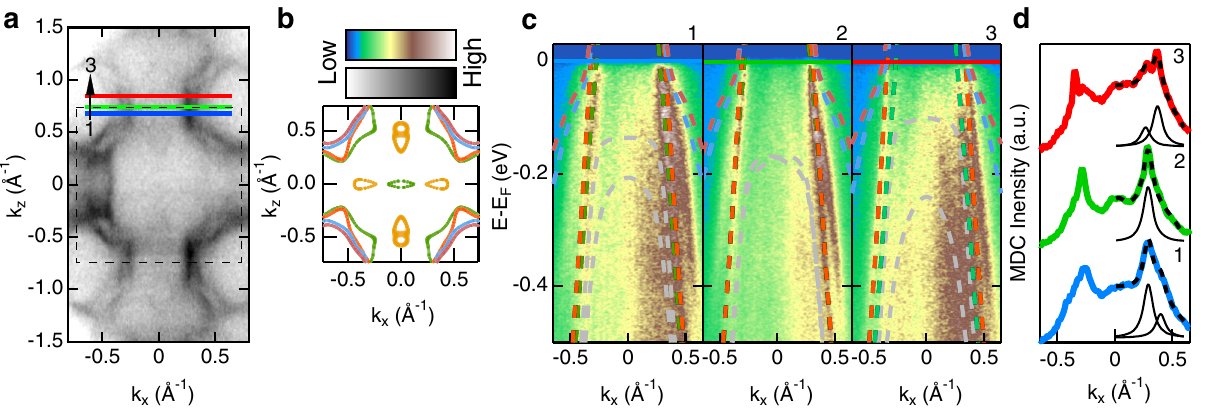
Fig. 3 ARPES measurements revealing the band touching on the nodal surface. Angle-resolved photoemission spectroscopy (ARPES) characterization of LaNiGa 2 . a Constant energy map with an integration window of ±10 meV around the Fermi energy, E F . The black dotted line indicates the boundary of the Brillouin zone in the k y = 0 plane. The blue, green, and red solid horizontal lines indicate cuts (1), (2), and (3) in panel c , respectively. b Calculated Fermi surfaces (FSs) on the k y = 0 plane with the colors corresponding to FSs in Fig. 2a. See Fig. S10c for an overlay of the ARPES and the calculated FSs on the k y = 0 plane. c Energy vs momentum spectra along cuts indicated in a . The dotted lines are the overlay of electronic structure calculations and the colors show which FSs are associated with each band. The gray bands are low energy bands which do not cross E F . d Momentum distribution curves (MDCs) at E F from the cuts in panel c . Spectra are fi t to one (two) Lorentzian peaks (dotted black curve) for cuts 2 (1,3), with a Gaussian background centered on k x = 0. The black curves below the experimental data are the individual Lorentzian peaks marking where the bands cross E F . The peak width for the Lorentzian fi t on 2 is a free fi tting parameter and fi xed to that width for the peaks of cuts 1 and